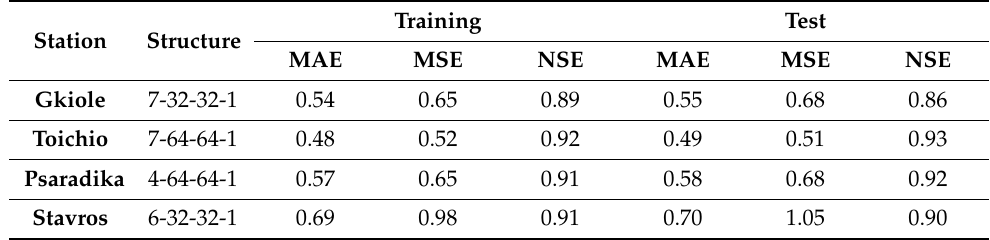
Table 4. The optimal selected structures for each